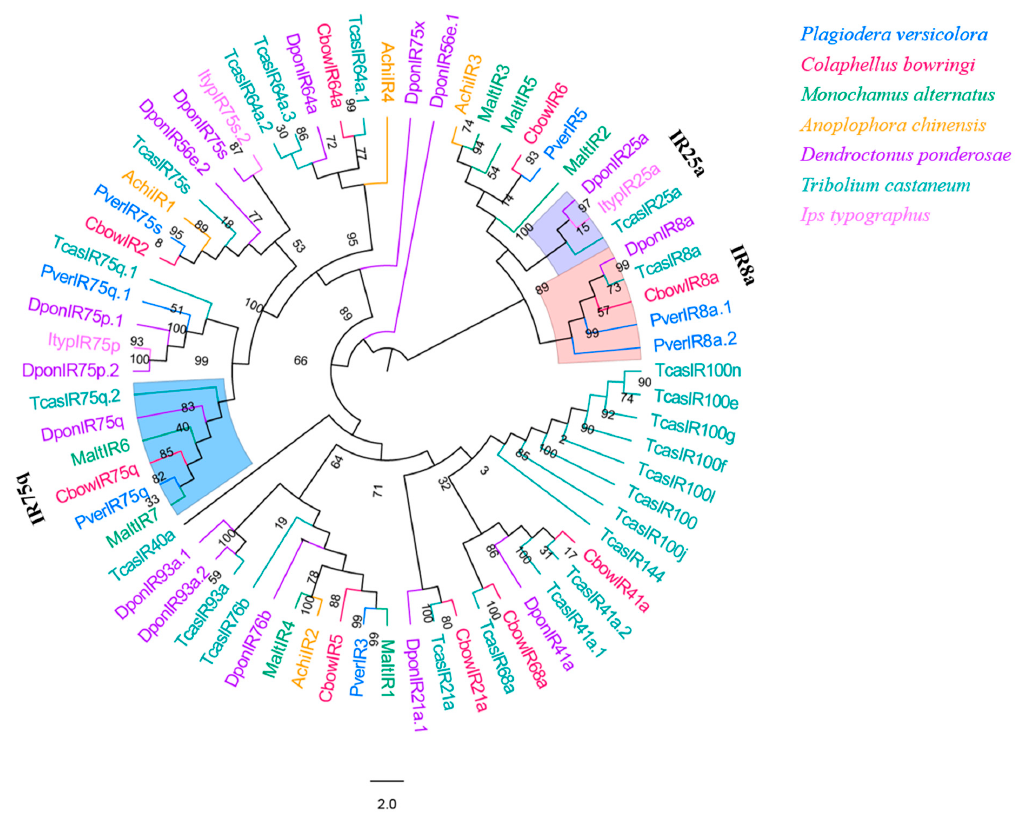
Figure 9. Phylogenetic tree of insect IR. The P. versicolora genes are shown in blue. The tree was constructed using MEGA6 with the Neighbor-joining method.